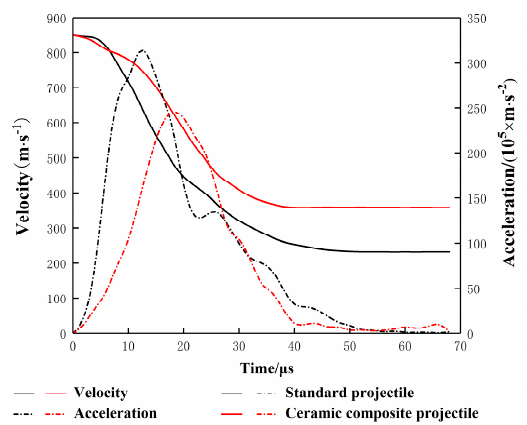
Figure 10. Projectile Core Velocity/Acceleration–Time Curve.